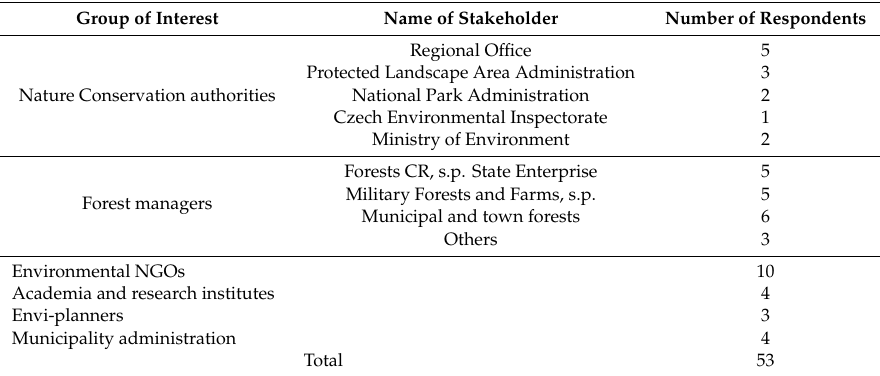
Table 2. List of stakeholders involved in the